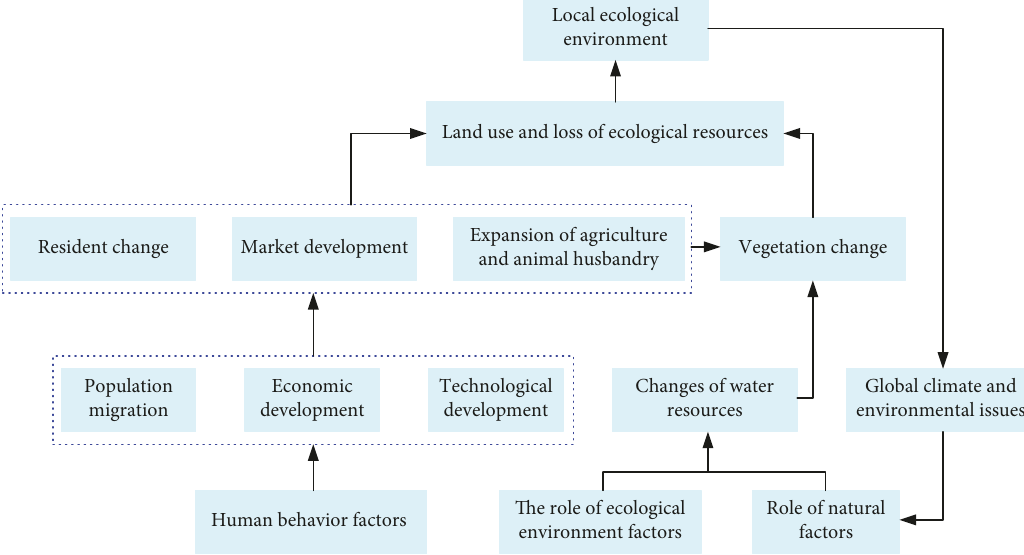
Figure 8: Ecological environment change and its influencing factors.